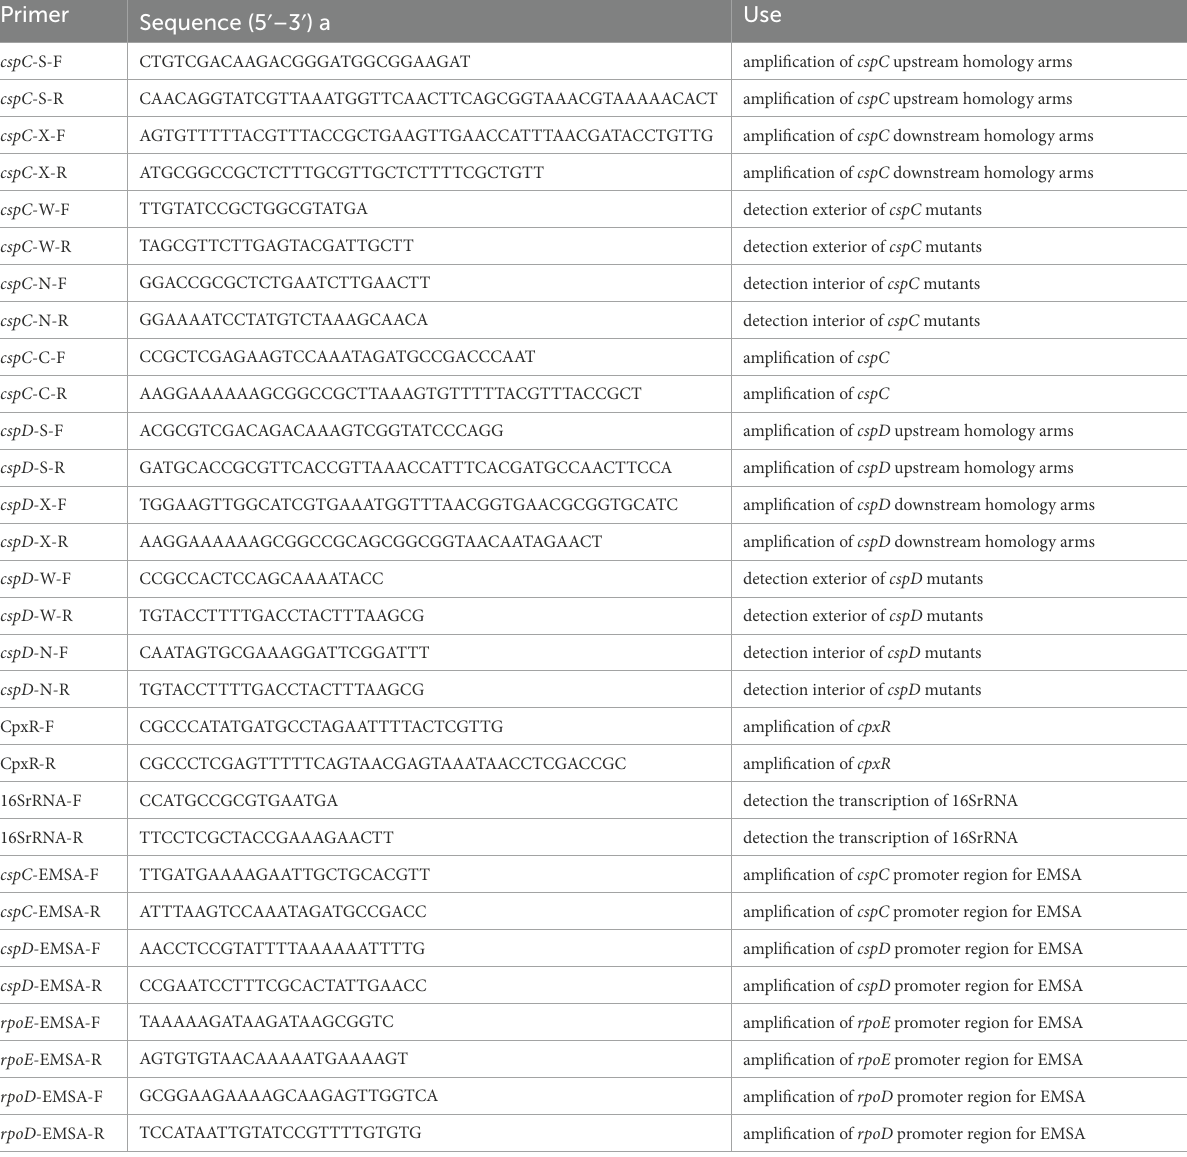
TABLE 2 Primers used in this